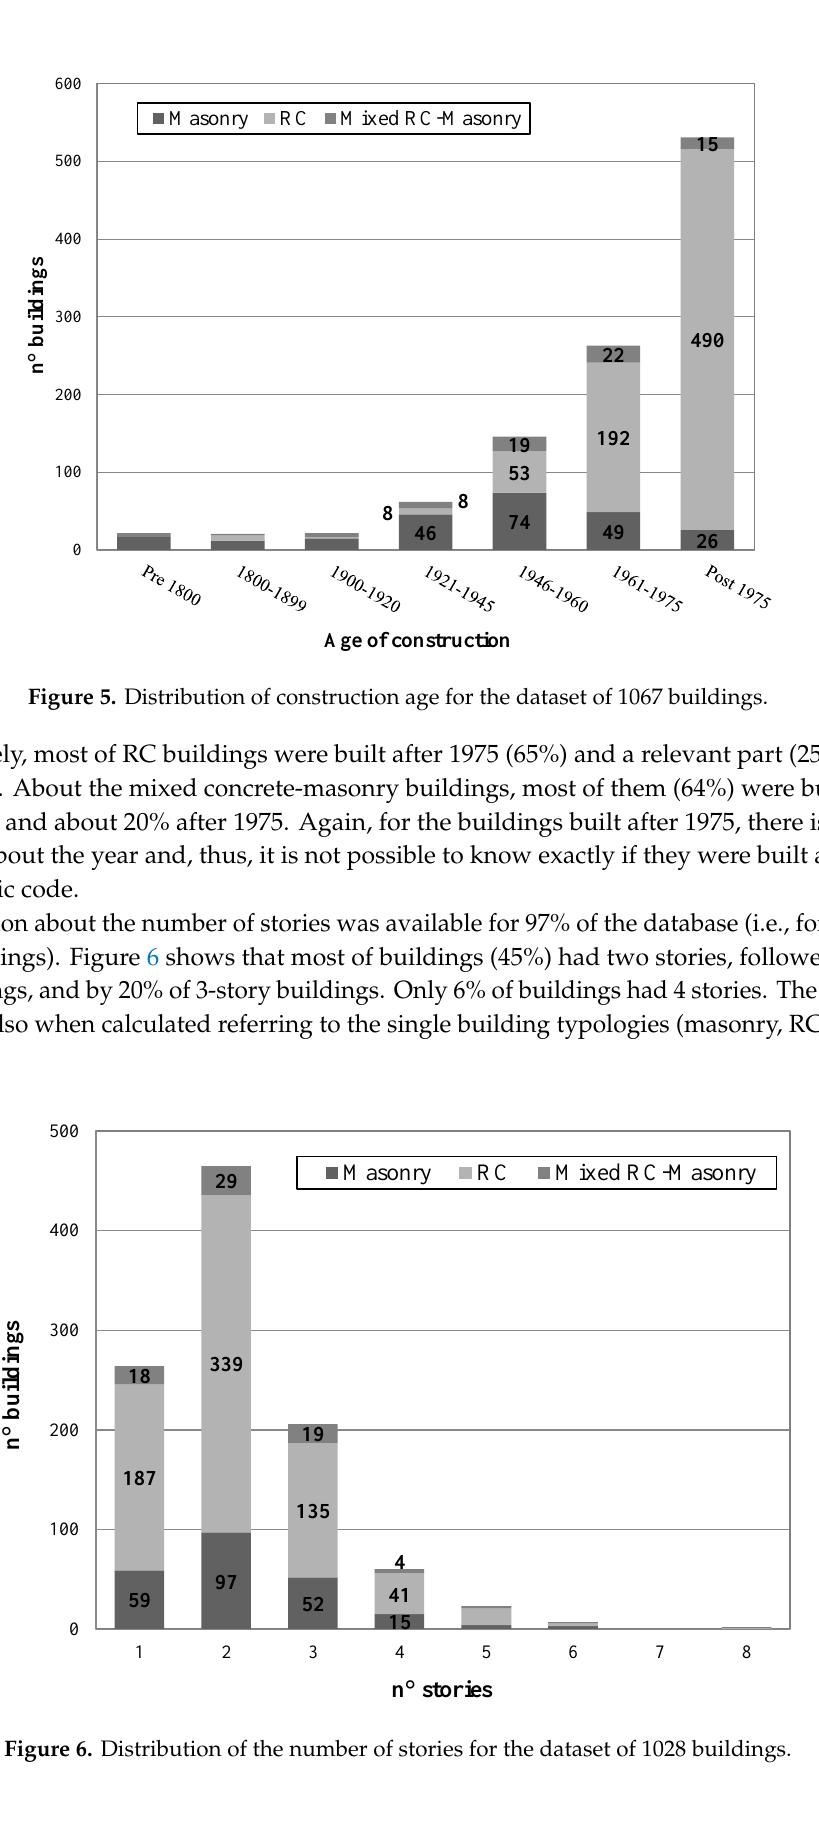
Figure 6. Distribution of the number of stories for the dataset of 1028 buildings.